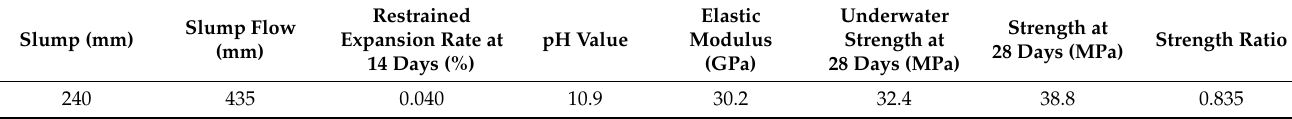
Table 2. Properties of the C30